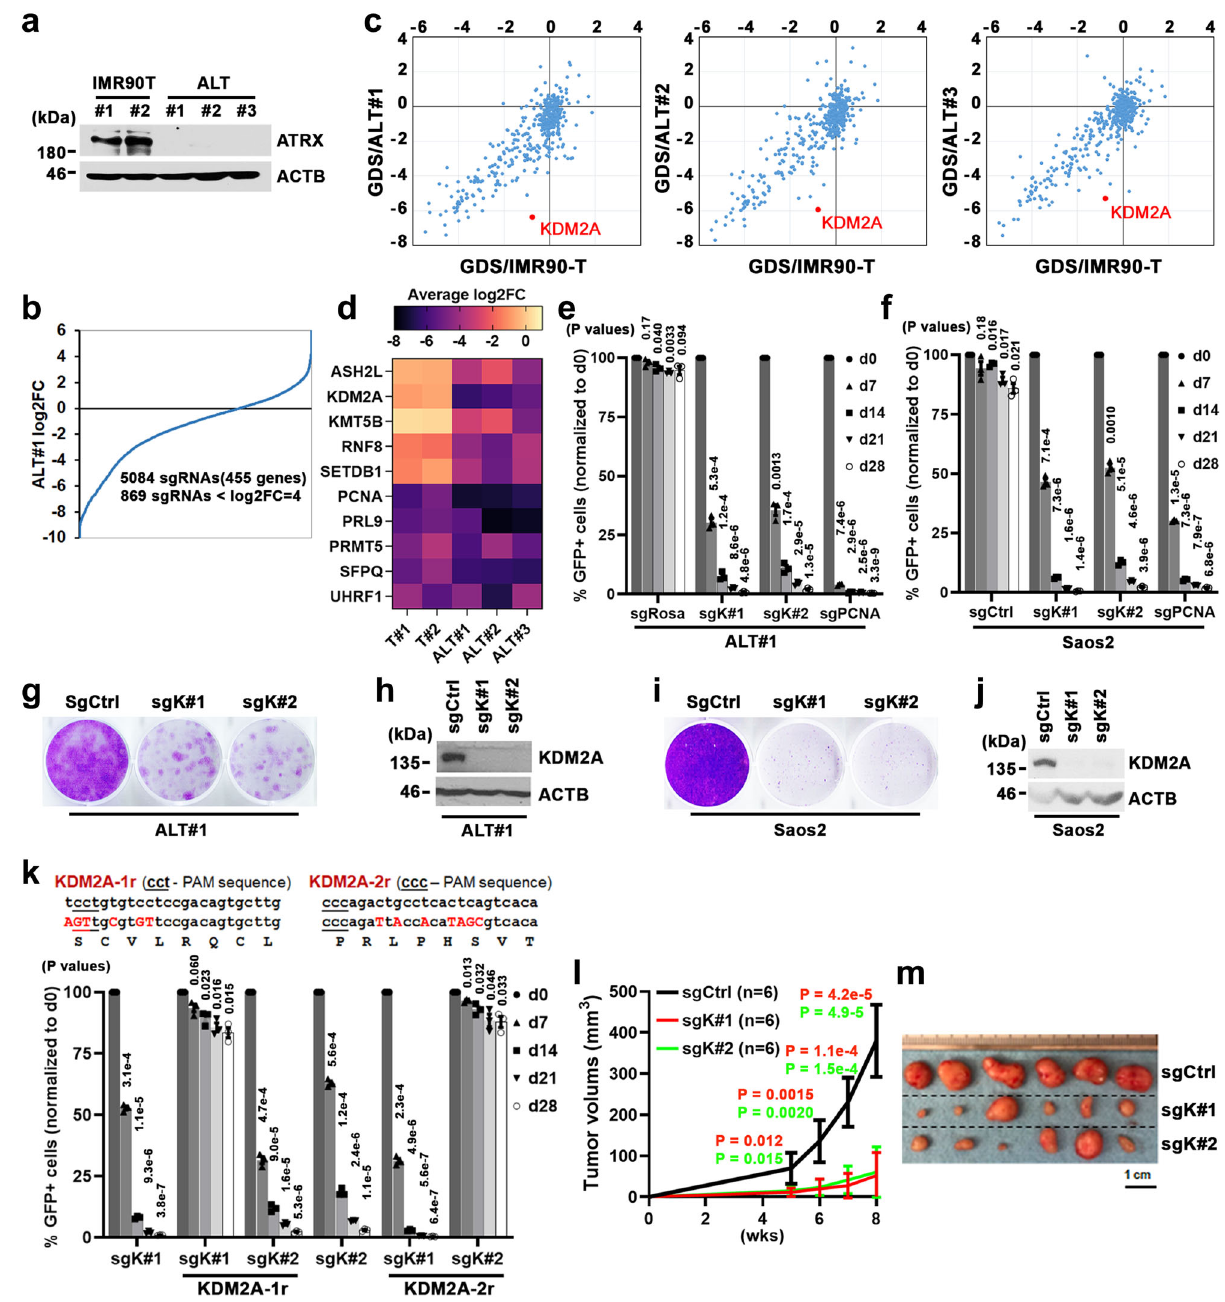
Fig. 1 | CRISPR-based screens identify KDM2A as selectively essential in ALT- dependent cells.a Western blot analysisofATRX protein expressionin whole-cell lysatespreparedfromtheindicatedcells. b RankingofsgRNAsbylog2fold-change (log2FC) of abundance (ratio of start to endpoint) in ALT#1 cells. the x-axis shows targeting sgRNAs; the y-axis shows the log 2 FC of each targeting sgRNA after 16 population doublings. c Gene dependencyscores (GDS)inIMR90-T (x-axis) versus ALT#1, ALT#2, or ALT#3 cells (y-axis). The GDS was calculated by averaging the log2FC of all sgRNAs targeting that gene. d Heatmap depicts log2FC of average sgRNA abundance of selected genes in indicated cells after 16 population dou- blings. e , f Competition-based proliferation assay of KDM2A -targeted sgK#1 and sgK#2 in ALT#1 ( e ) or Cas9-expressing Saos2 cells ( f ). A GFP reporter is linked to sgRNAexpression.Plottedisthe%GFPcells(normalizedtothed0measurement)at the indicated time points. The non-targeting sgCtrl wasincluded as a negative and sgRNA targeting PCNA as a positive control. g , h Clonogenic assay ( g ) and KDM2A